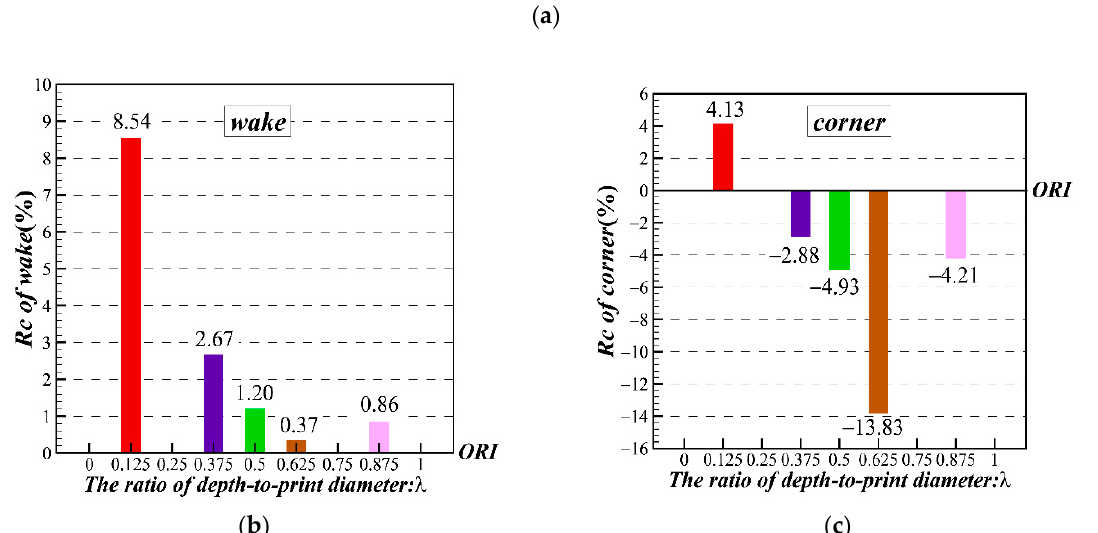
Figure 11. The total pressure loss coefficient of the outlet. ( a ) The loss along spanwise direction; ( b ) the loss in the wake; ( c ) the loss in the corner.